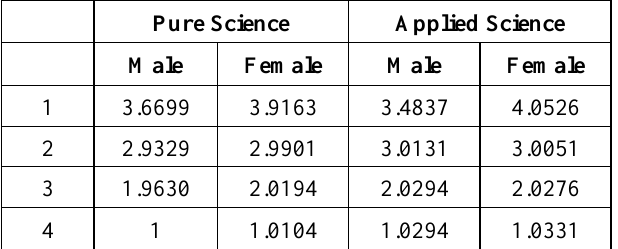
Table 10. Expected duration of study before graduating